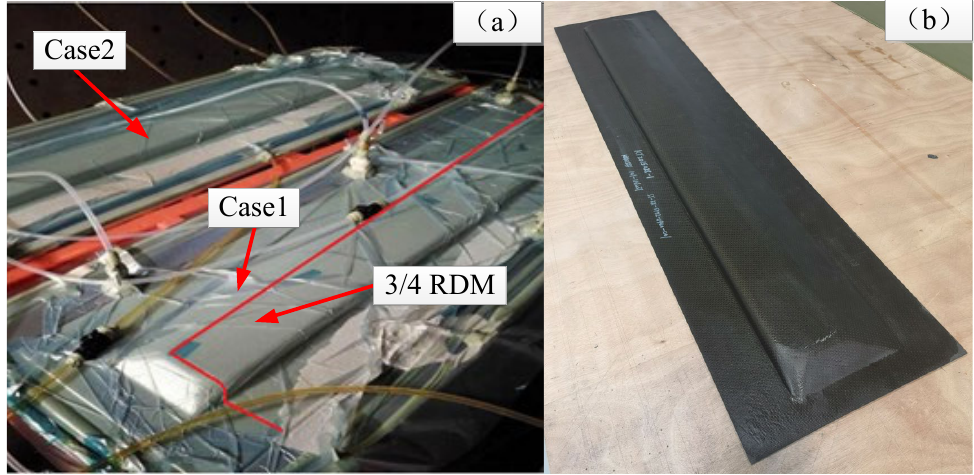
structure slope to the T1 position is longer, and the resin pressure is gradually lost along the length direction, resulting in lower pressure at the T1 position, and this phenomenon lasts until the T2 position, which affects the final structure quality. Therefore, Case 1, in which resin is injected from the thicker side of the spoiler component, is more suitable for improving the manufacturing quality of spoilers. Based on these analyses, the injection scheme of the simulation Case 1 was adopted to fabricate the spoiler.